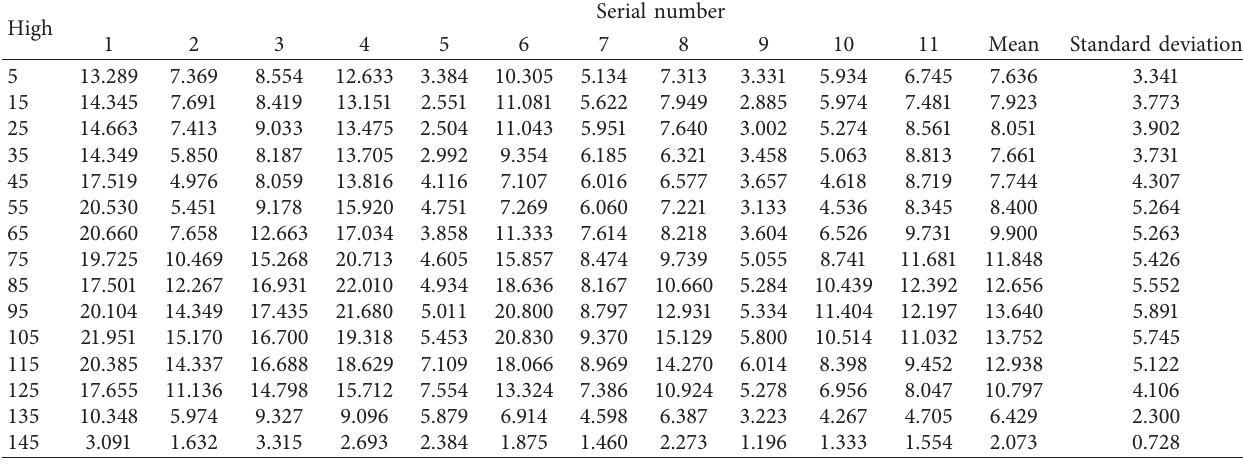
Table 6: Maximum earthquake compressive stresses of the 150m chimney under the action of 11 earthquake waves ignoring vertical